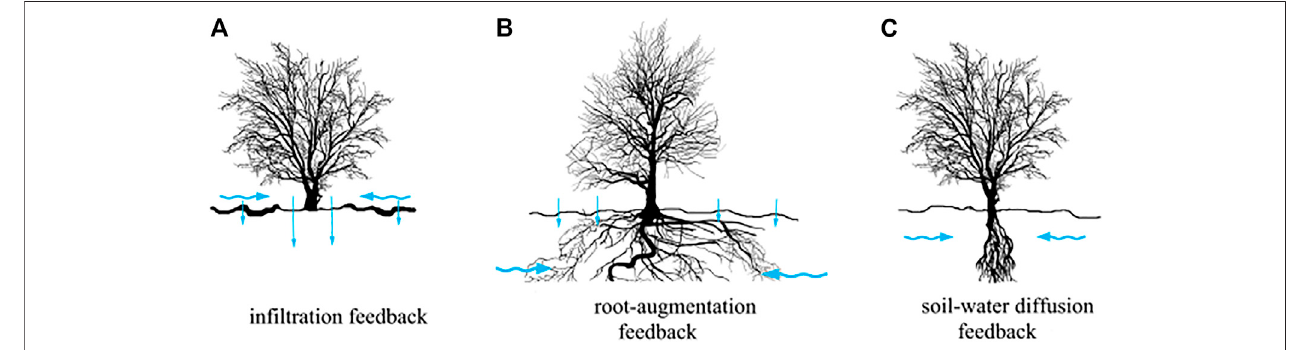
FIGURE 2 | Schematic diagram of three feedback mechanisms between vegetation and water. (A) Difference of in fi ltration rate between bare soil and vegetation coveredareacausessurfacewater fl ow, (B) vegetationrootsextendlaterallytoabsorbwater,and (C) soilwaterdiffusivityexceedthespreadofvegetationbiomass.The blue arrow indicates the direction of water fl ow, and the length of the straight arrow represents the size of in fi ltration rate.